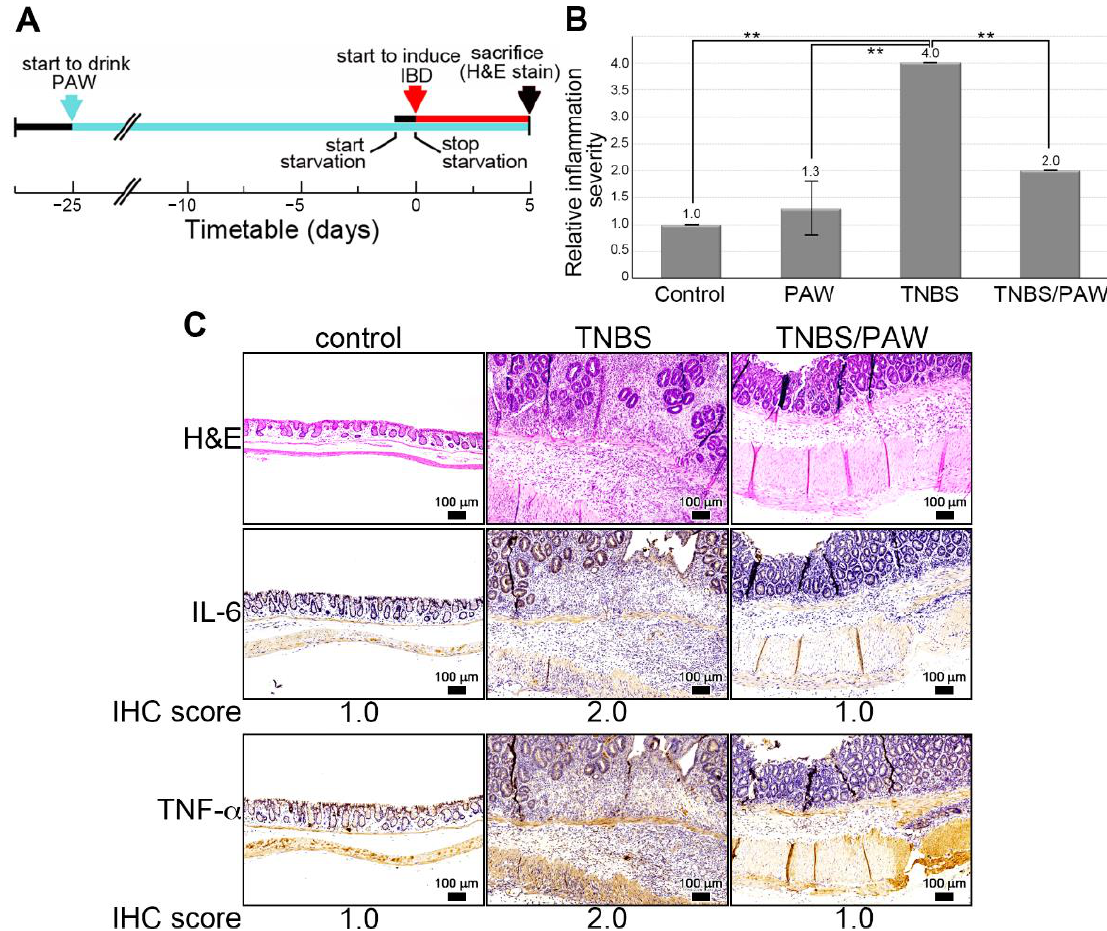
Figure 2. TNBS-induced IBD in mice drinking PAW. ( A ) Experimental protocol for TNBS-induced IBD and PAW consumption. The colors of the arrows denoted the time to start PAW consumption (light blue), induced IBD (red), and end experiment (black). ( B ) Histological score of inflammation in different groups. Score for inflammation severity: 1, none; 2, mild; 3, moderate; 4, severe. ( C ) Representative images of H&E-stained and IHC staining colon sections of mice with TNBS induction and PAW consumption. IL-6 and TNF- α were used as the proinflammatory cytokines. IHC score for the percentage of positively stained cells: 1, 0 – 25%; 2, 26 – 50%; 3, 51 – 75%; 4, 76 – 100%. TNBS, 2,4,6-trinitrobenzene sulfonic acid; PAW, plasmon-activated water; H&E, hematoxylin and eosin; IHC, immunohistochemistry. Scale bars, 100 μm. ** p < 0.01.